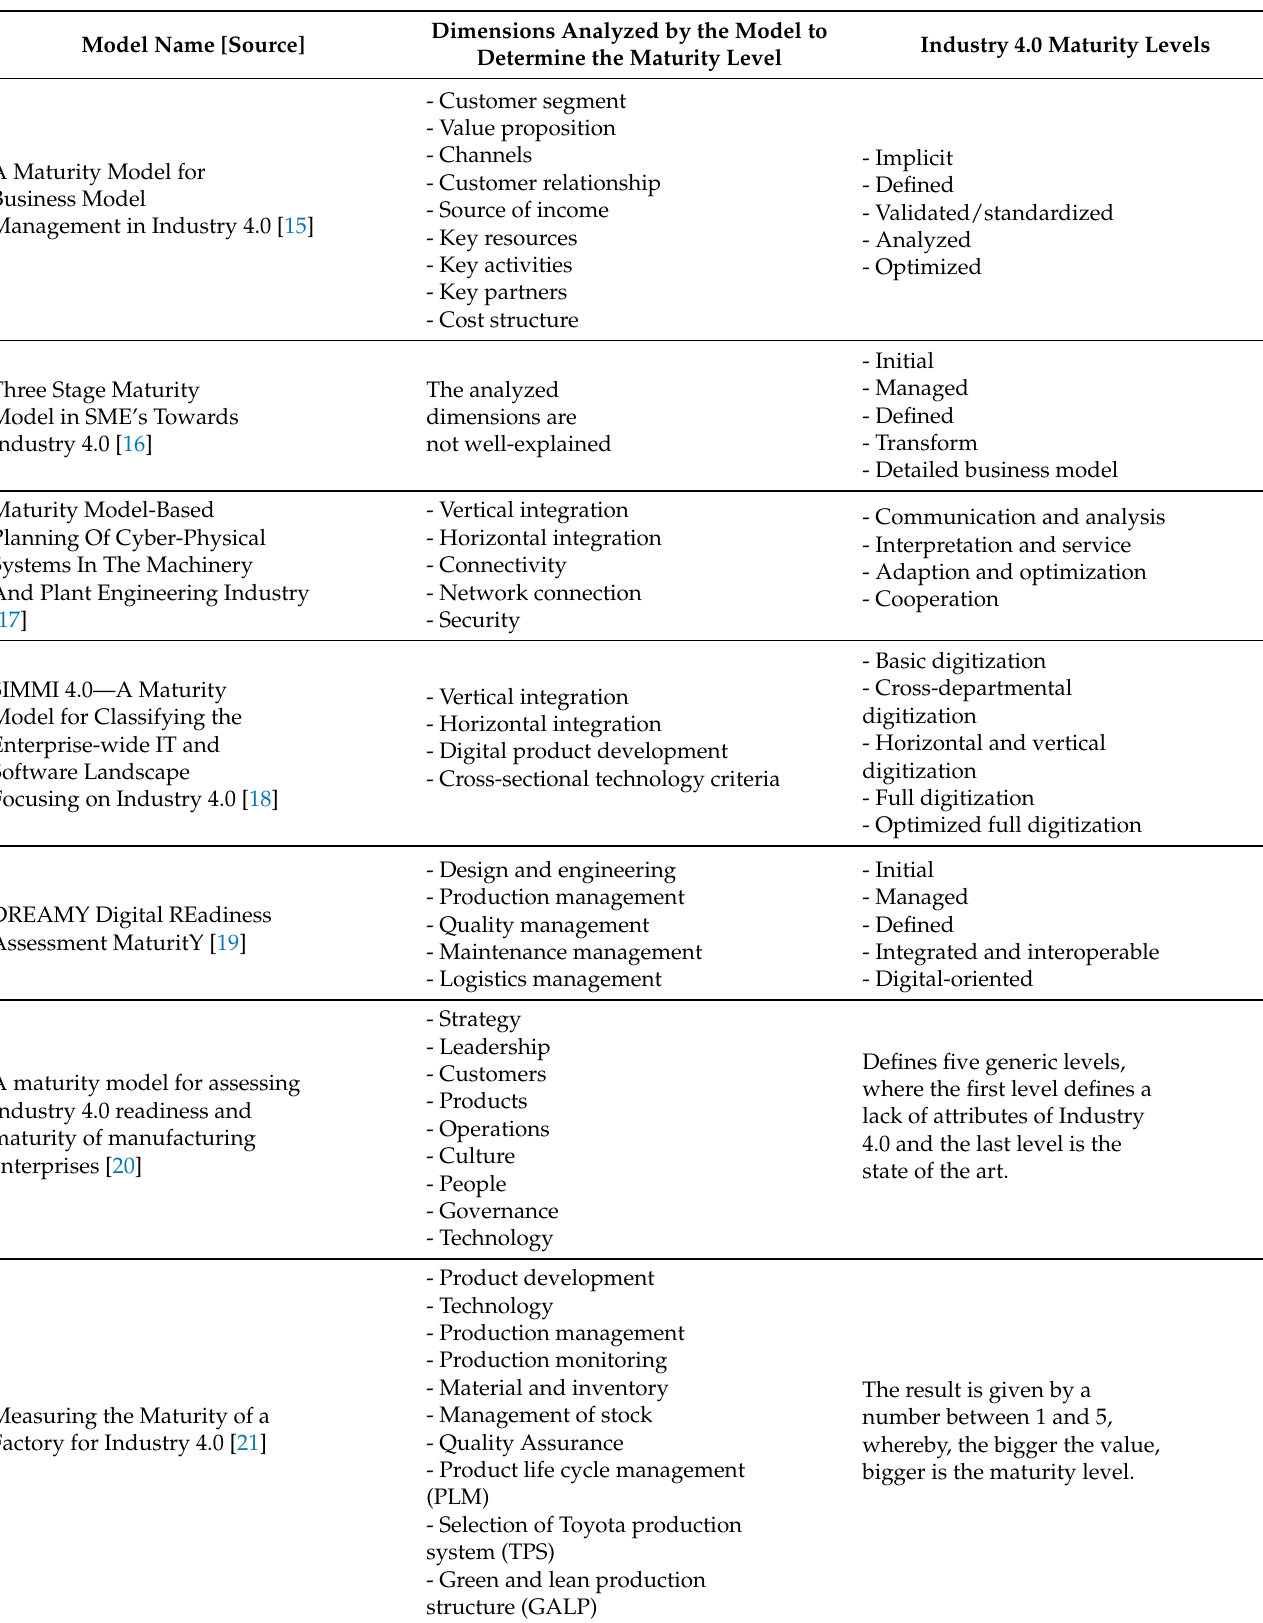
Table 1. Related work overview: existing Industry 4.0 readiness and maturity